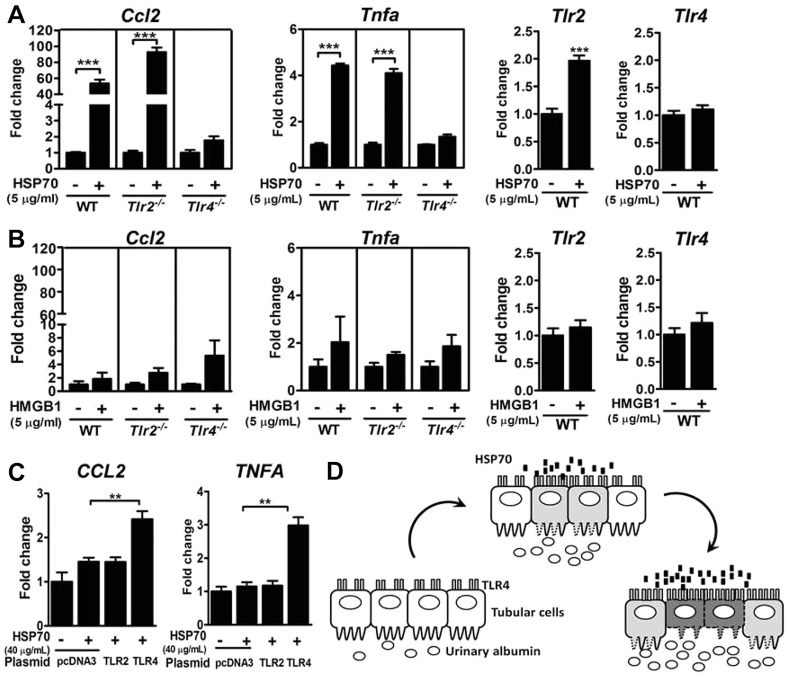
TLRs in DAMP-induced inflammatory response. Expression of Ccl2, Tnfα, Tlr2 and Tlr4 in mPTCs from Tlr2−/−, Tlr4−/− and WT mice treated with 5 µg/ml human HSP70 (A) and 5 µg/ml human HMGB1 (B) for 8 h. ***P<0.001 by Student's t-test. (C) Expression of CCL2 and TNFA in TLR2- and TLR4/CD14/MD2-overexpressing HEK293T cells treated with 40 µg/ml human HSP70 for 8 h. **P<0.01 by one-way ANOVA followed by Dunnett's test. (D) The proposed model of the albumin-HSP70-TLR4 axis in renal tubular inflammation.